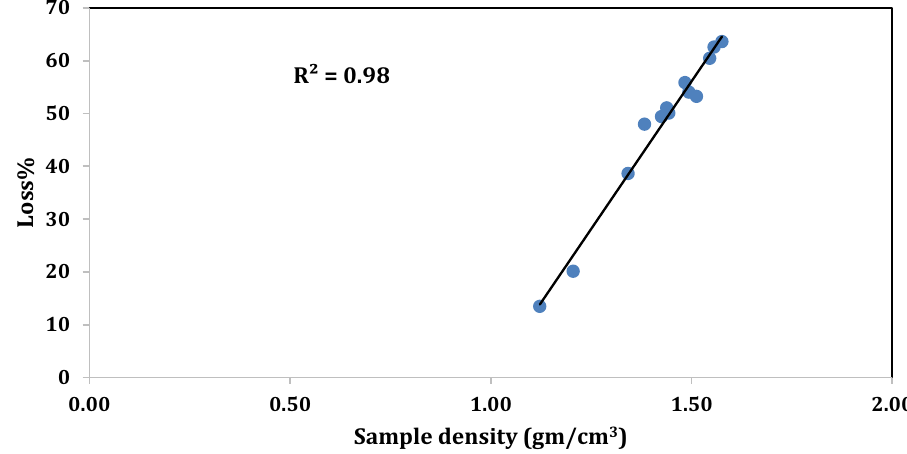
Fig. 6 Correlation between Loss percent of Radon and sample density